Question: Draft a figure caption describing what is shown.
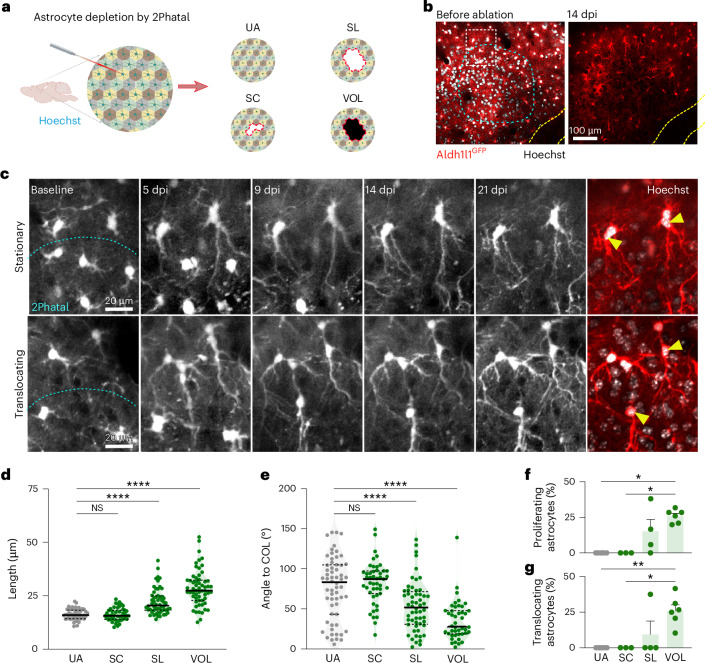
Answer: Astrocyte nucleokinesis is inducible by volume-targeted 2Phatal approach. a , Experimental setup for astrocyte ablation by modified 2Phatal method in different configurations—UA, that is, area without ablation but with in vivo Hoechst staining, SC (~5 cells, 0.08–0.14 × 10 6 µm 3 ), SL (~1.3–2.2 × 10 6 µm 3 ), VOL (~6.3–10 × 10 6 µm 3 ). b , Overview of the ablation region in Aldh1l1 GFP mice before (left) and 14 days after 2Phatal laser ablation (right). The cyan dashed line encompasses the ablation area, white dashed square indicates region of zoom-ins shown in c . In vivo Hoechst-33342-stained nuclei for 2Phatal induction are shown in white; astrocytes are shown in red, yellow dashed lines indicate a nearby blood vessel. Image is representative of similar results observed in six lesions from six mice. c , Representative two-photon in vivo time-lapse images of perilesional astrocytes 1–21 days after 2Phatal VOL ablation in Aldh1l1 GFP mice. The cyan dashed line indicates the border of the 2Phatal ablated area. The slow disappearance of 2Phatal-targeted astrocytes within 2 weeks was noted. At the last imaging time point, Hoechst 33342 (in white) was added to counterstain for nuclei (astrocytes are shown in red). Stationary (top) and translocating (bottom) daughter-cell nuclei are indicated by yellow arrowheads. Image is representative of similar results observed in six lesions from six mice. d , e , Vector-based quantification of process length ( d ) and polarization ( e ; UA— n = 45 astrocytes from three animals, SC— n = 47 cells from three animals, SL— n = 56 cells from four animals, VOL— n = 59 cells from six animals). **** P < 0.0001; Mann–Whitney test, two sided. Thick black lines represent the median, and fine black dashed lines represent the first and third quartiles. f , g , The percentage of proliferative ( f ) and repopulating ( g ) astrocytes, respectively, showing an increase with larger ablation volumes (UA— n = 5 animals, SC— n = 3 animals, SL— n = 4